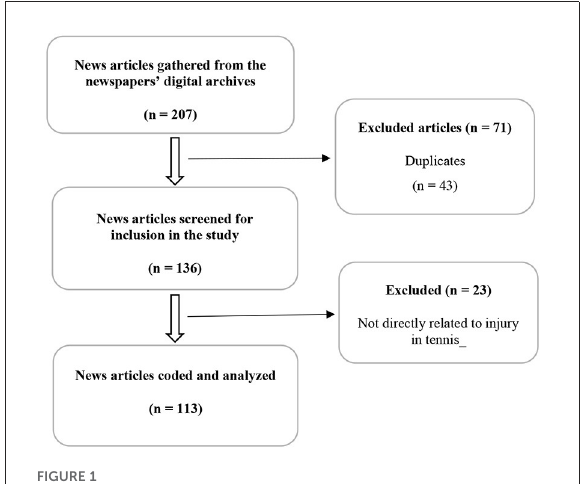
FIGURE1 Inclusion and exclusion